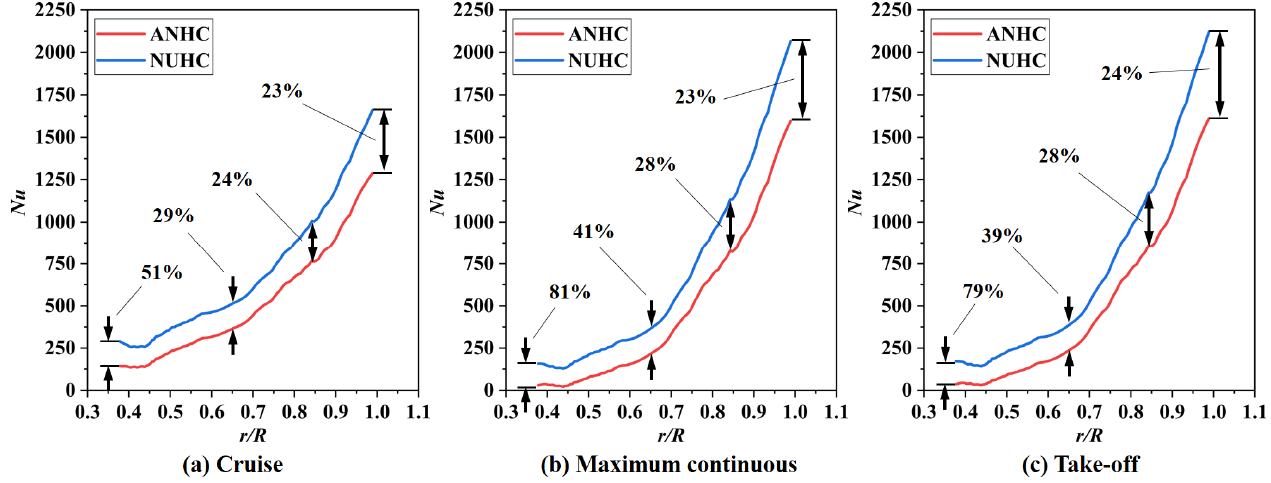
Figure 26. Nusselt numbers under ANHC and NUHC.